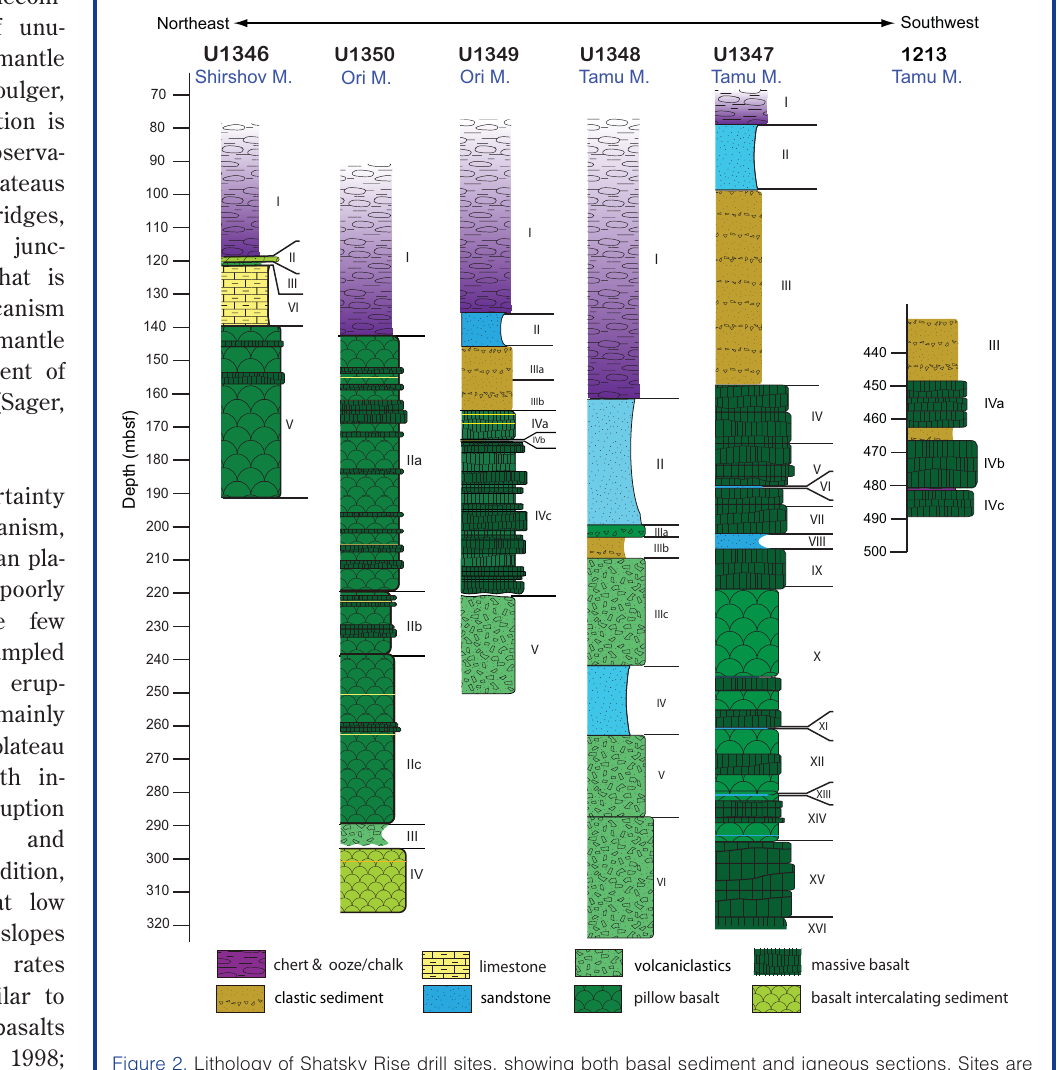
Figure 2. Lithology of Shatsky Rise drill sites, showing both basal sediment and igneous sections. Sites are arranged in transect order, from northeast (left) to southwest (right). Site 1213 from ODP Leg 198 (Shipboard Scientific Party, 2002) is shown at the same scale for completeness. Roman numerals indicate lithologic units, which are described in the Expedition Reports (Sager et al.,